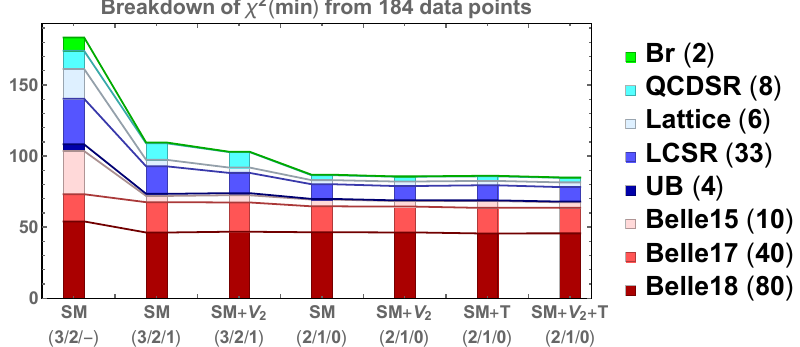
Figure 2 . The breakdown of the (cid:31) 2 deviations at our best (cid:12)t results from the 184 data points. Finally, we show a summary plot for the predictions on R scenarios in (cid:12)gure 1 (bottom), where the allowed regions for SM(3 = 2 = 1), SM + V and SM + V (2 = 1 = 0) are shown in red, blue, and green, respectively. The combined ex- 2 perimental result (gray curves) and the referred SM prediction (red bar) are taken from ref.